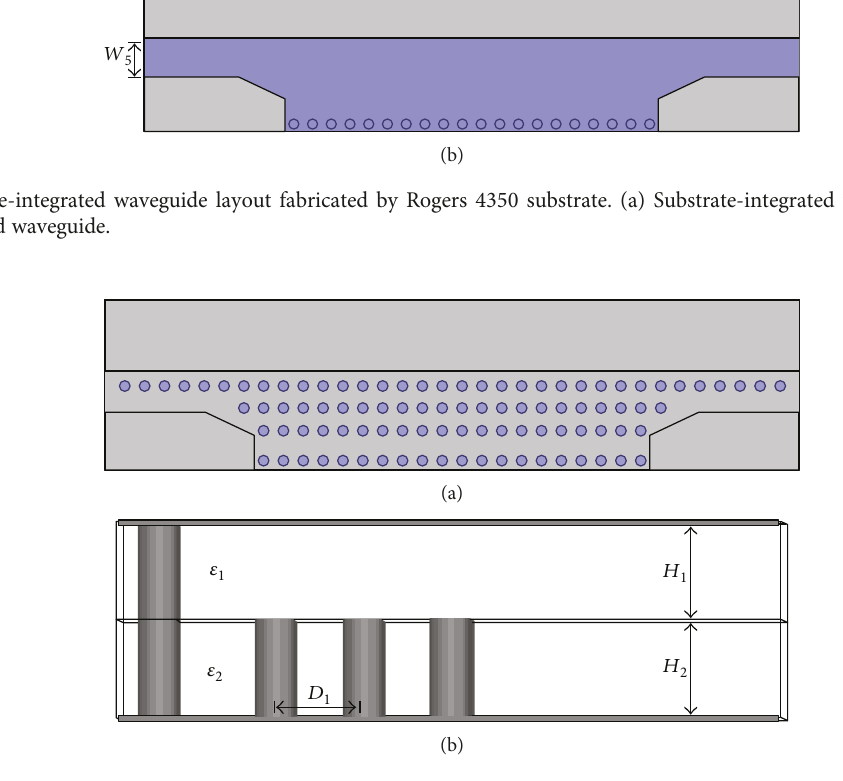
Figure 2: Slow-wave substrate-integrated waveguide layout fabricated by Rogers 4350 substrate. (a) Top view; (b) cross-section view. Table 1: Values of substrate-integrated waveguide geometry parameters designed on Rogers 4350 substrate (all units in